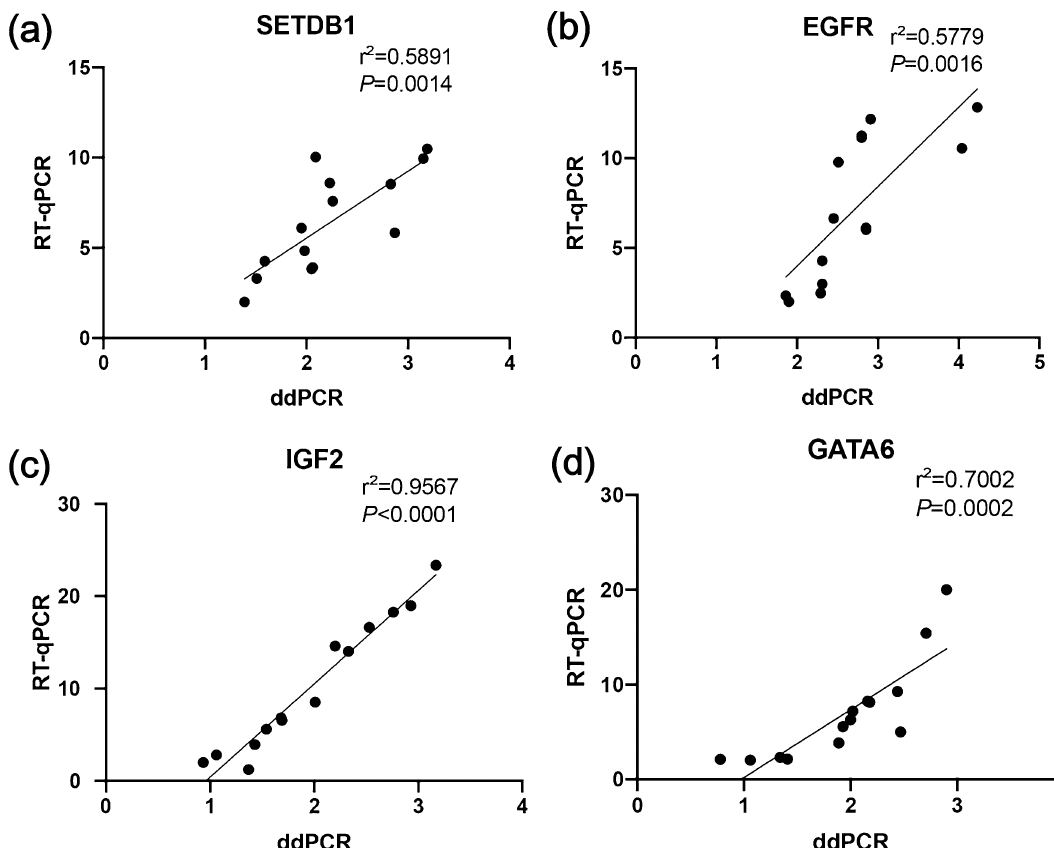
Figure 2. Correlation between RT-qPCR and ddPCR measurements. mRNA expression levels of SETDB1 ( a ), EGFR ( b ), IGF2 ( c ), and GATA6 ( d ) were measured in triplicate in 14 gastric cancer cell lines. For RT-qPCR, each dot represents the mean of the technical